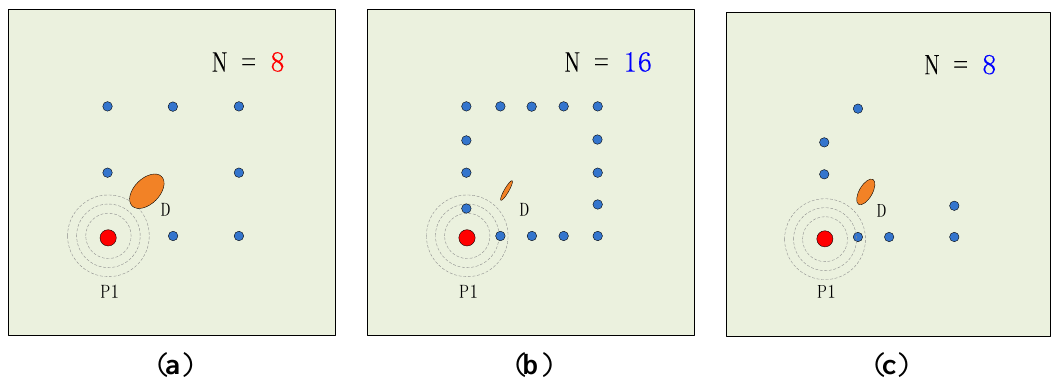
Figure 6. The scheme of the sparse sensor optimization method. ( a ) 8 Transducers